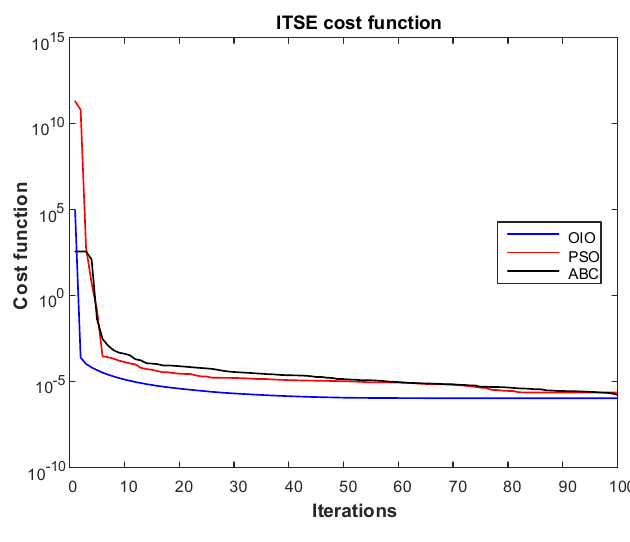
Figure 18. Iteration history for ITSE.